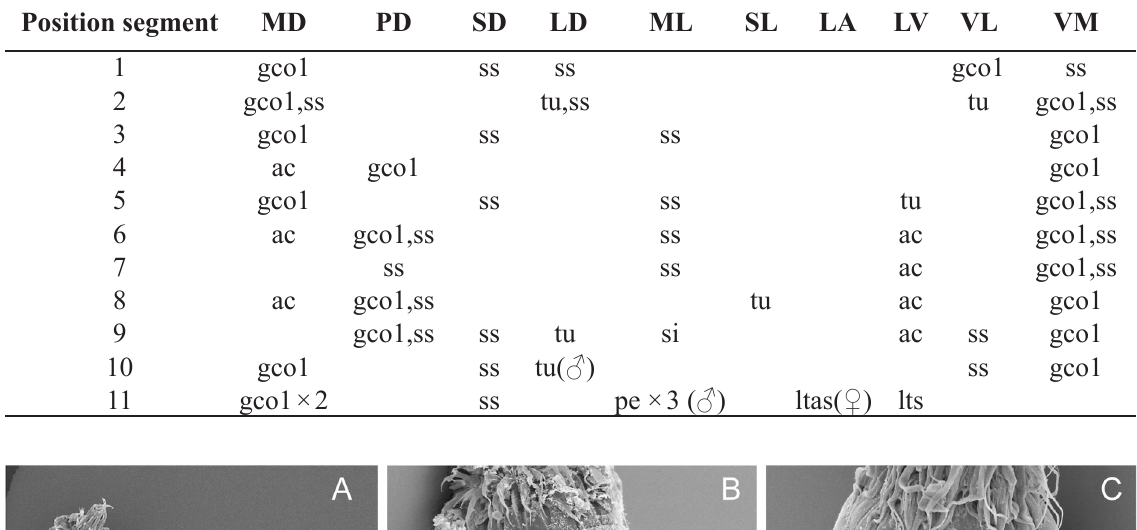
Table 9. Summary of nature and location of sensory spots, glandular cell outlets, tubes and spines arranged by series in Echinoderes leduci sp.